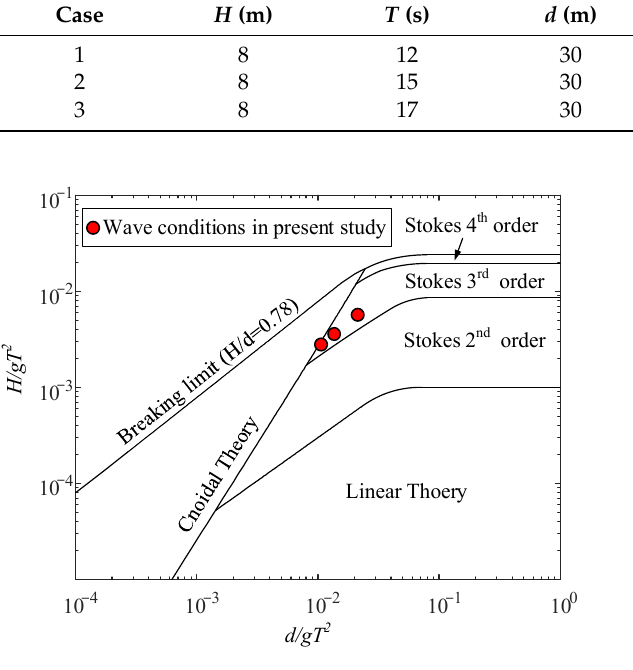
Figure 8. Limits of validity for various wave theories (Le Méhauté [50]).